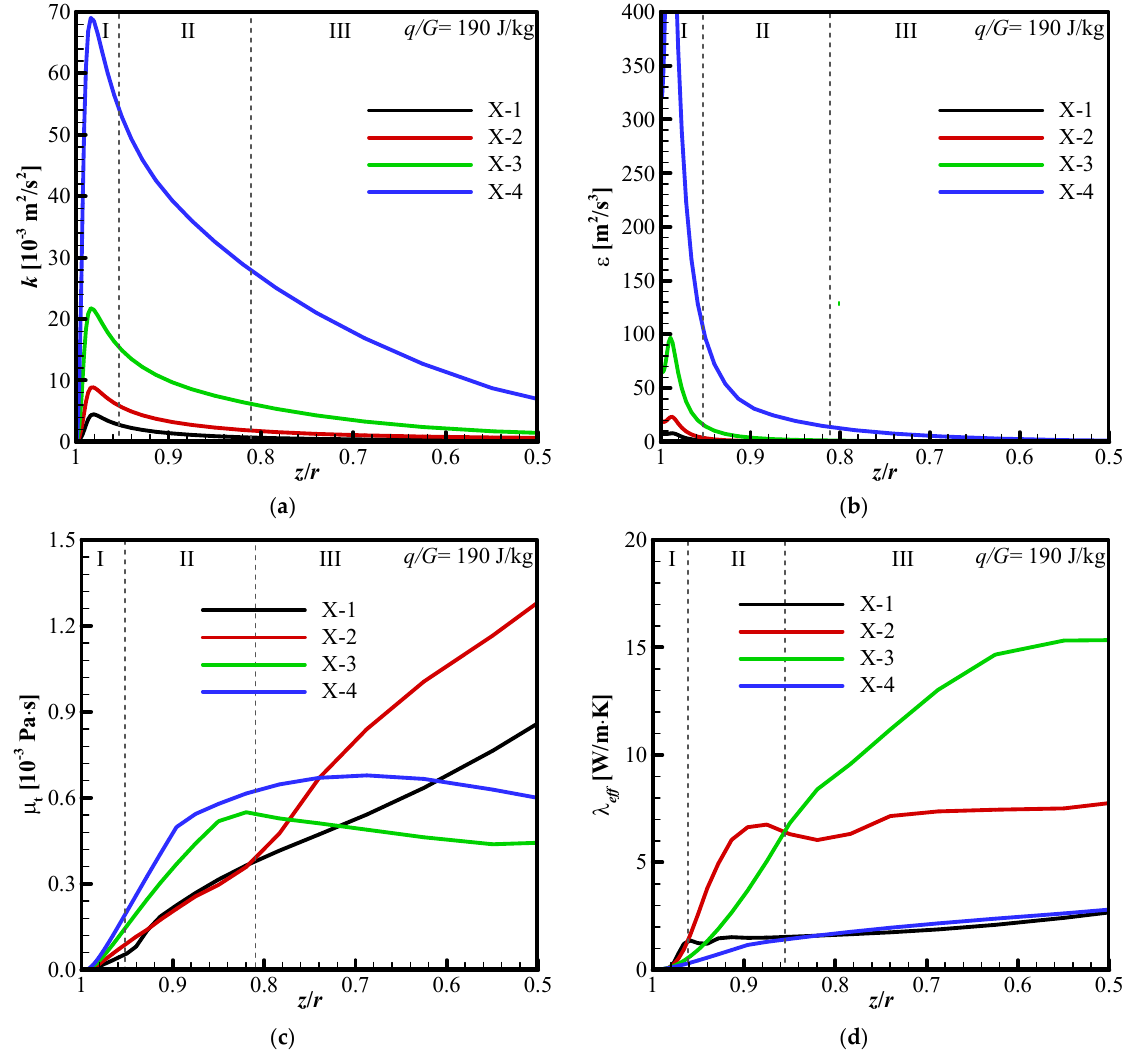
Figure 11. Radial variations at four different axial locations for the case with q / G = 190 J/kg at p = 3.8 MPa and G = 385 kg/m 2 · s: ( a ) turbulent kinetic energy; ( b ) turbulent dissipation rate; ( c ) turbulent viscosity; ( d ) effective ther- mal conductivity. z / r = 1 and 0 denote the wall and centreline of the tube,